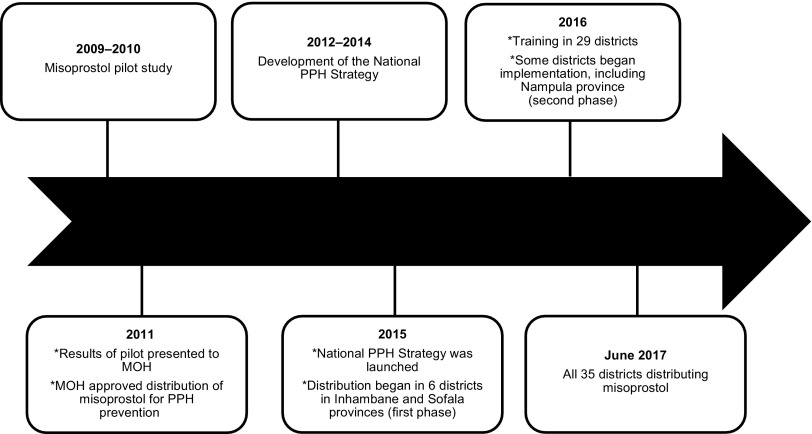
The Evolution of the Distribution of Misoprostol for Prevention of Postpartum Hemorrhage in Mozambique